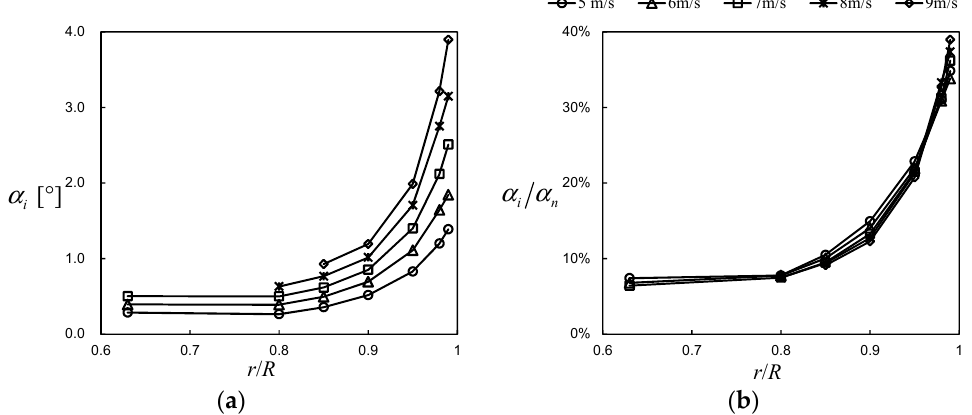
Figure 15. Variation of the downwash angle along the blade span: ( a ) downwash angle; ( b ) the ratio of downwash angle to nominal